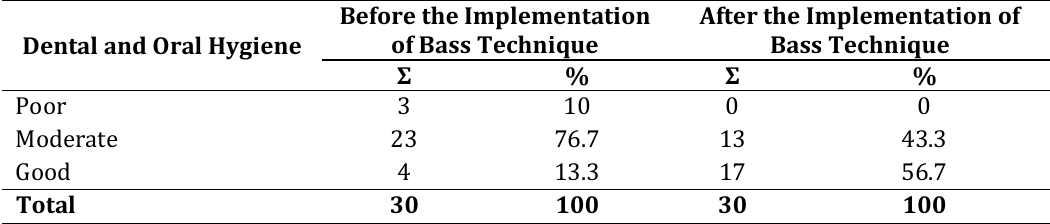
Table 2 Dental and Oral Hygiene Before and After the Implementation of the Toothbrushing Simulation Method with the Bass